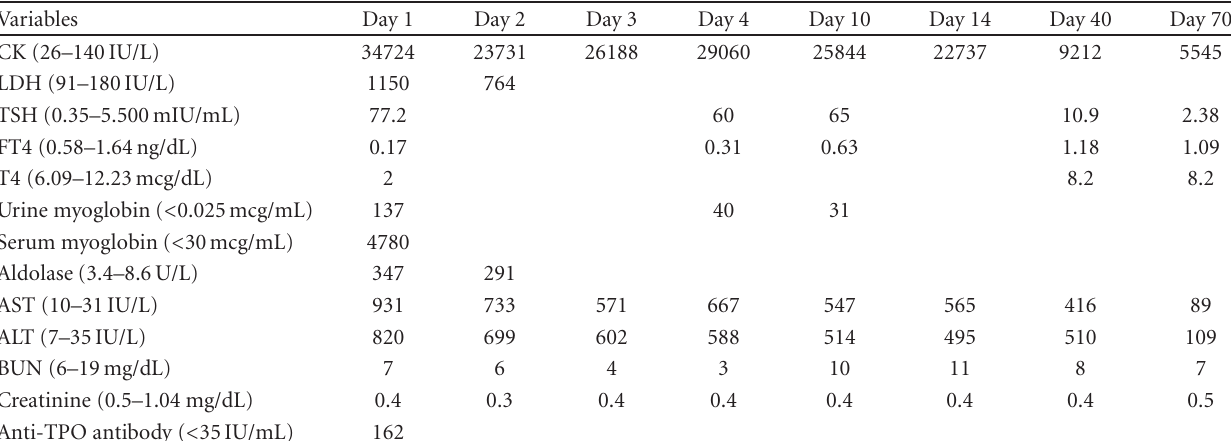
Table 1: Patient’s laboratory